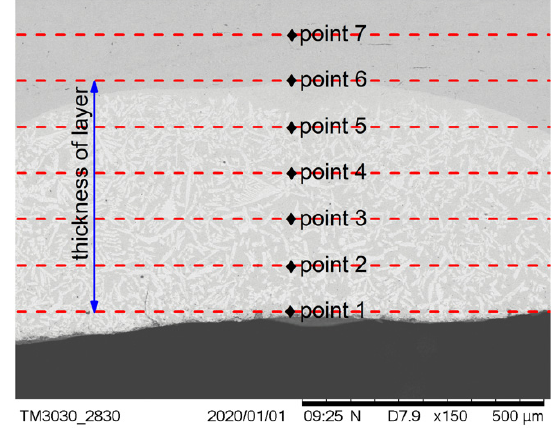
Figure 8. Positions of the hardness measurements.